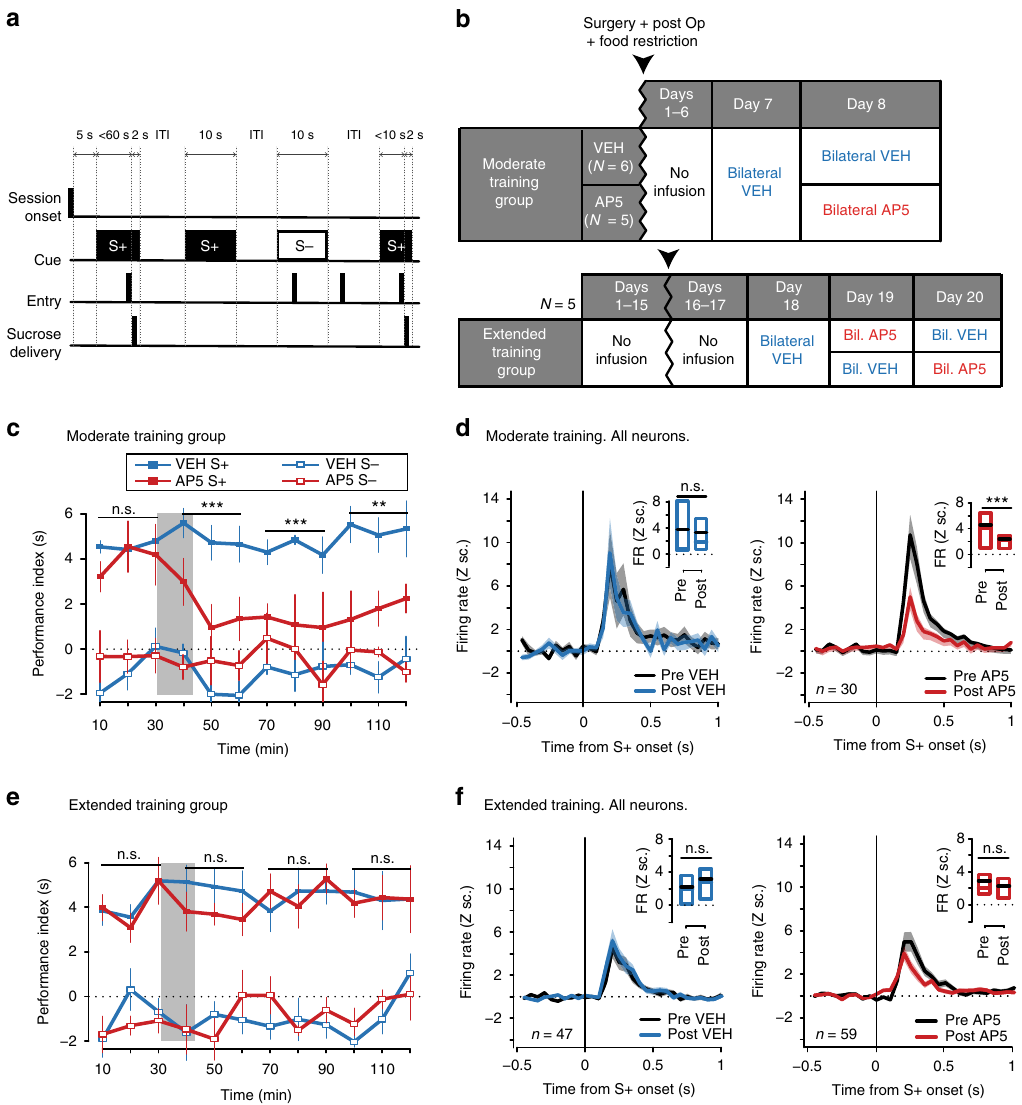
Fig. 4 NMDARs transiently mediate the expression of cued NAc activity and approach behavior. a Task. ITI: intertrial interval. b Microinjection schedule. c For the moderate training group, performance index in S + (solid) and S − trials (empty squares) before and after saline (VEH, blue) or AP5 (red) microinjection (mean ± SEM). The gray rectangle represents the microinjection period. In S + trials, AP5-treated subjects performed worse than subjects in the control group in every post-injection 30 min bin (*** p < 0.001; ** p < 0.01; t test). d Firing rate (FR; mean ± SEM) in Z scores (Z sc.) around S + onset in the moderate training group before (gray) or after injection of saline (blue, left) or AP5 (red, right). Insets show activity 100 – 400 ms after S + before (pre) or after (post) injection. Boxes show the interquartile range (box height), mean (black line), and median (red/blue line). Activity was unaffected by saline ( p = 0.64), but reduced by AP5 injections (*** p < 0.001, Wilcoxon). e , f Same as in c , d , but for animals in the extended training group. In this group, performance was not disrupted by AP5 injections ( p > 0.05, t test). S + -evoked activity was also unaffected by saline ( p = 1) or AP5 injections ( p =